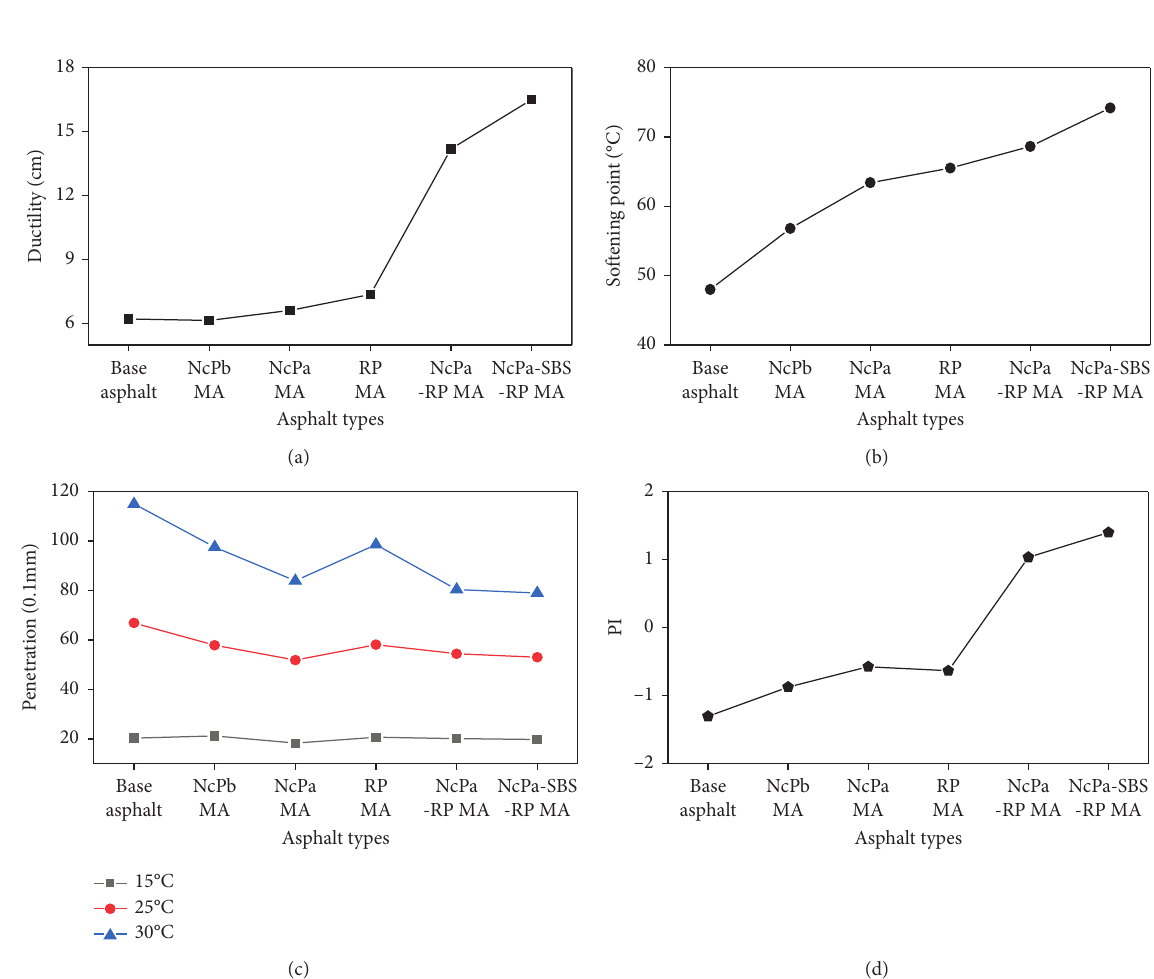
Figure 3: Regular physical index of each asphalt sample. (a) Ductility at 5 ° C. (b) Softening point. (c) Penetration at 15 ° C, 25 ° C, and 30 ° C. (d) PI